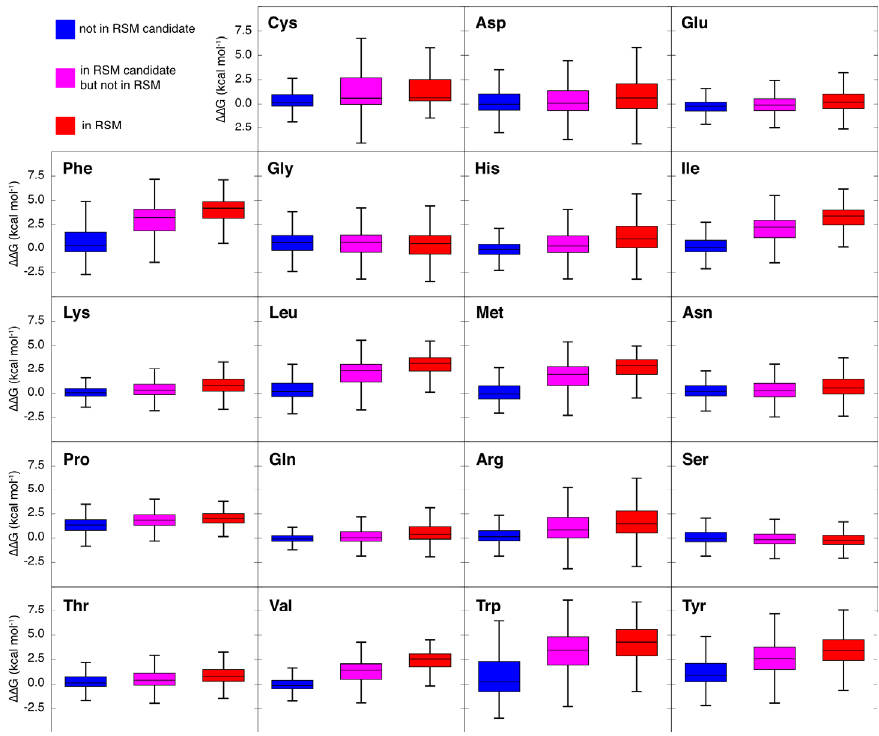
Figure 8. Folding free energies (kcal mol − 1 ) from computational alanine scanning calculations, shown for each kind of non-Ala residue. Values in red are those for residues that take part in RSMs. Values in magenta are those for residues that were considered in RSM candidates, but that turned out to be non-recurrent. Values in blue are for residues that are never part of any RSM candidate. The tops and bottoms of the boxes indicate the upper and lower quartiles ( i.e. , Q 3 and Q 1, respectively) of each corresponding sample, and the whiskers indicate the corresponding highest and lowest value inside the bound given by Q 3 + 1.5 · IQR and Q 1  1.5 · IQR , respectively (where IQR denotes the so-called interquartile range, Q 3  Q 1). The line within each corresponding box indicates the median of each